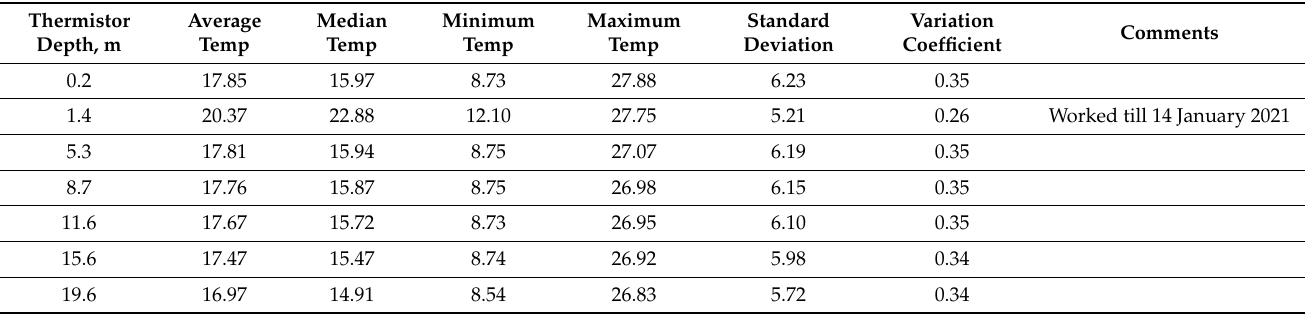
Table 2. Statistical parameters of water temperature at different depths during the second measure-